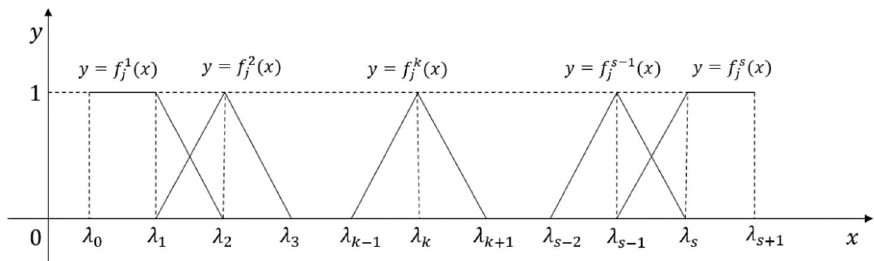
Figure 4. Modified central-point triangular whitenization weight function.